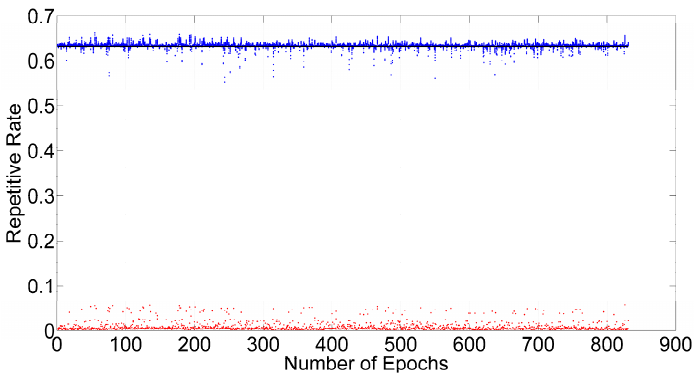
Figure 5. Repetitive rates of 21 satellites with two cycle slips (blue dots for valid satellites, red dots for satellites with cycle slips, and black line for theoretical value).